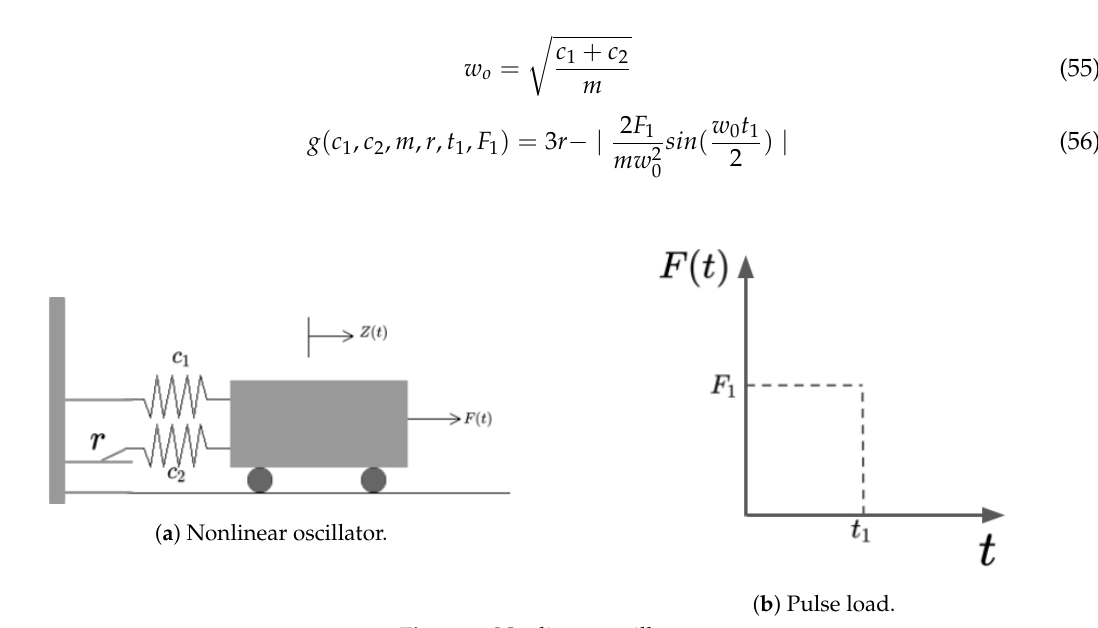
Figure 4. Nonlinear oscillator.